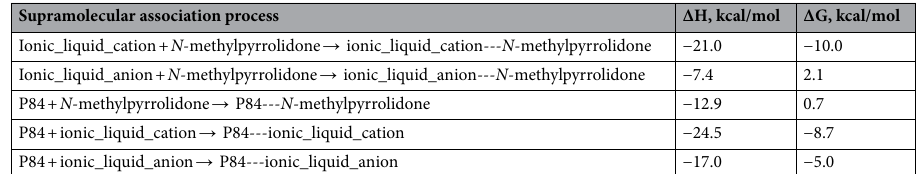
Supramolecular association